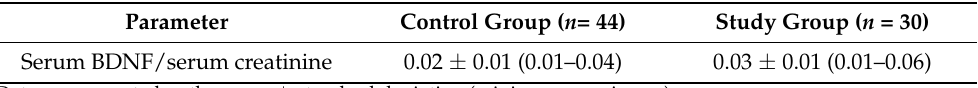
Table 2. Serum BDNF to serum creatinine ratio assessed in study and control group. Parameter Control Group ( n = 44) Serum BDNF/serum creatinine Data are presented as the mean ± standard deviation